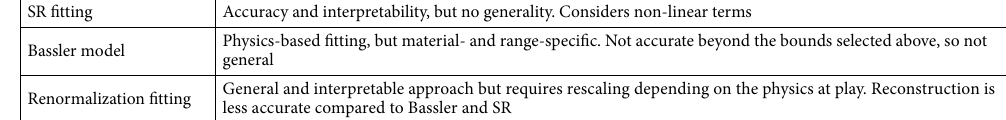
Table 2. A qualitative comparison of the three fitting approaches—Symbolic Regression, Bassler model and Renormalization model, as inferred from our